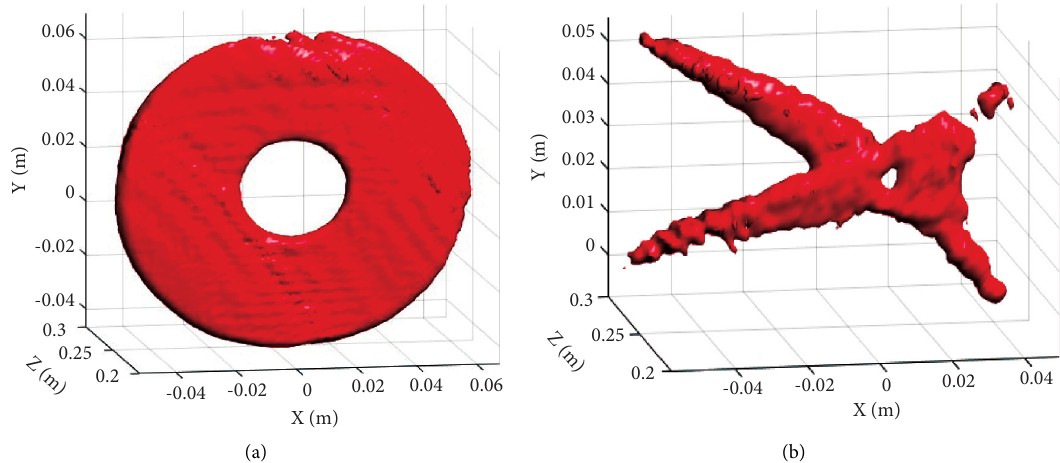
Figure 7: Reconstructed 3D images of targets with RMA: (a) disc; (b) scissors.